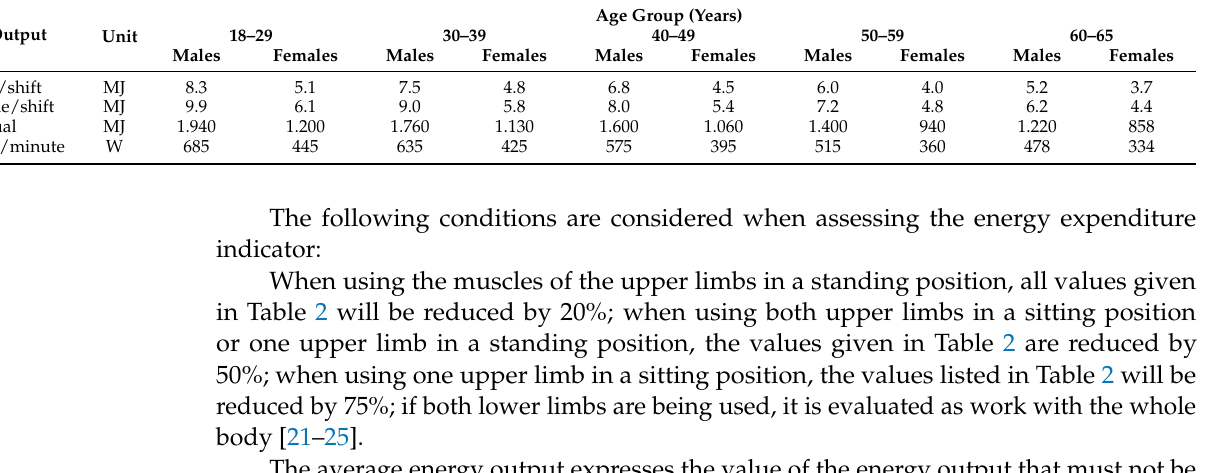
Table 2. Permissible values of energy output and heart rate as the physiological indicators of the workload [9]. Energy Output Unit